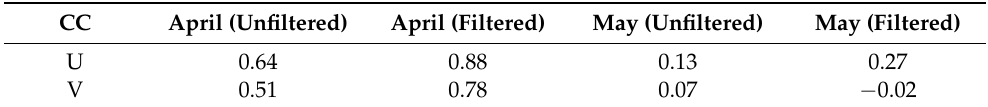
Table 9. Correlation coefficient between filtered and unfiltered observed and modeled wind stress in April and May